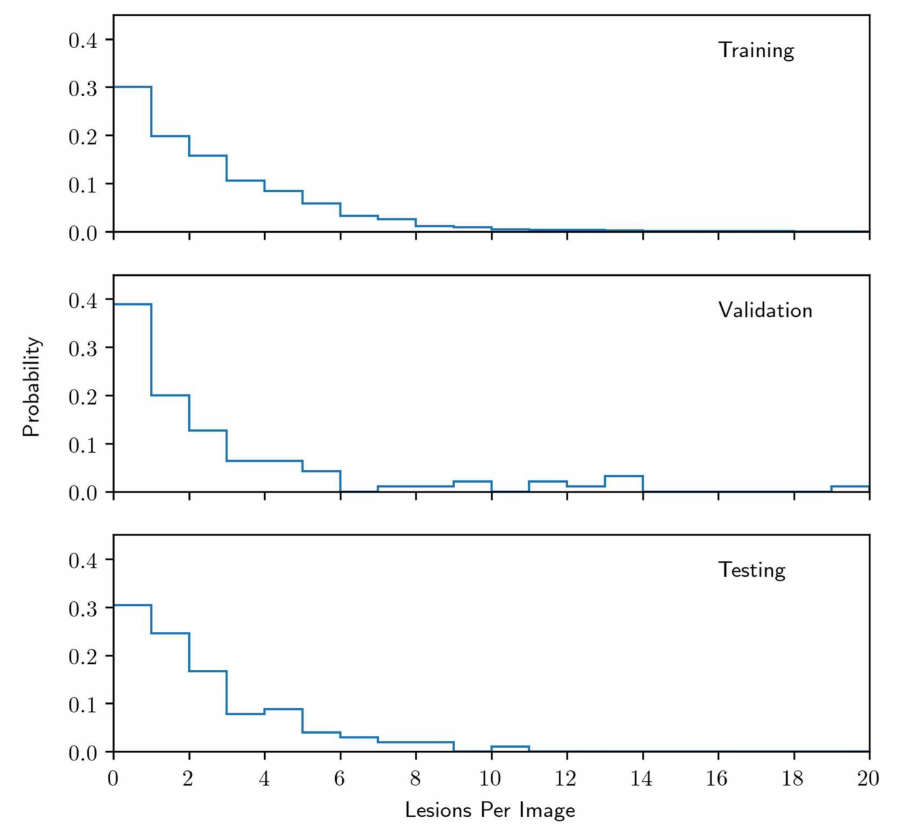
Figure 1. Distribution of radiolucent periapical alterations per image for the training data set, the validation data set, and the testing data